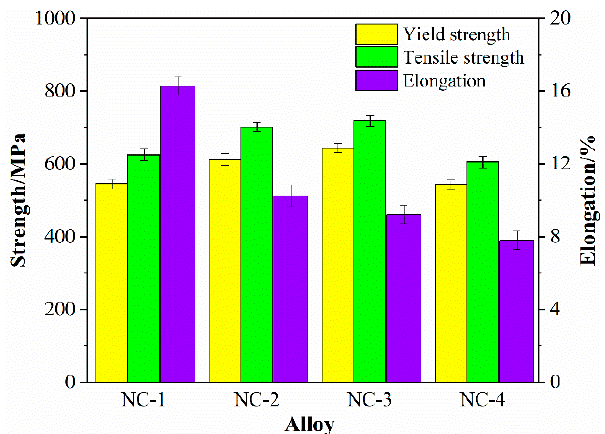
Figure 2. Comparison of mechanical properties of the tested alloys at the peak aging state.